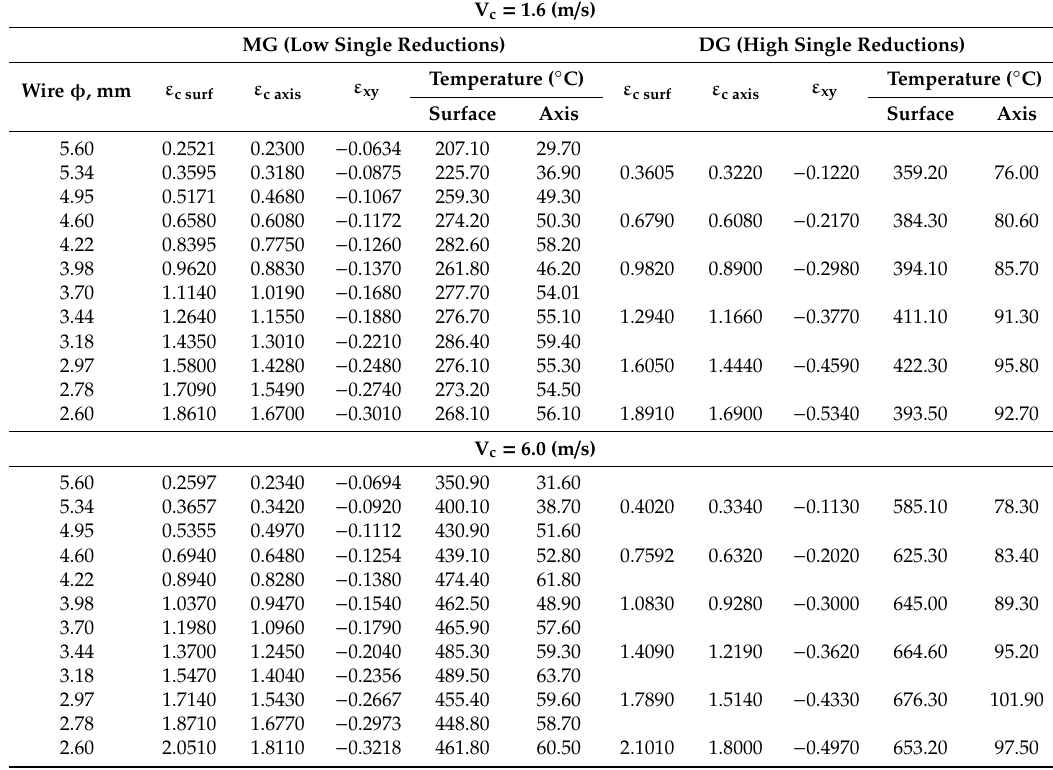
Table 10. The strain level on the wire surface and axis, non-dilatational strain and the temperature determined through a theoretical analysis of the drawing process with low (MG) and high (DG) single section reductions and at various drawing speeds (V c = 1.6 m / s and V c = 6.0 m / s). V c = 1.6 (m / s)